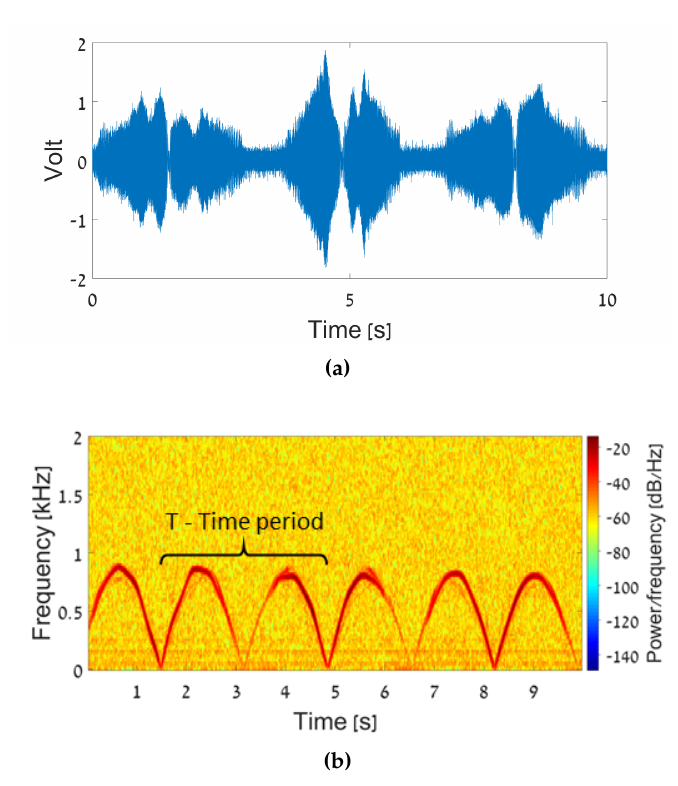
Figure 5. The measurement results with the physical pendulum: ( a ) The intermediate frequency (IF) signal in the time domain. ( b ) Spectrogram of the micro-Doppler frequencies.